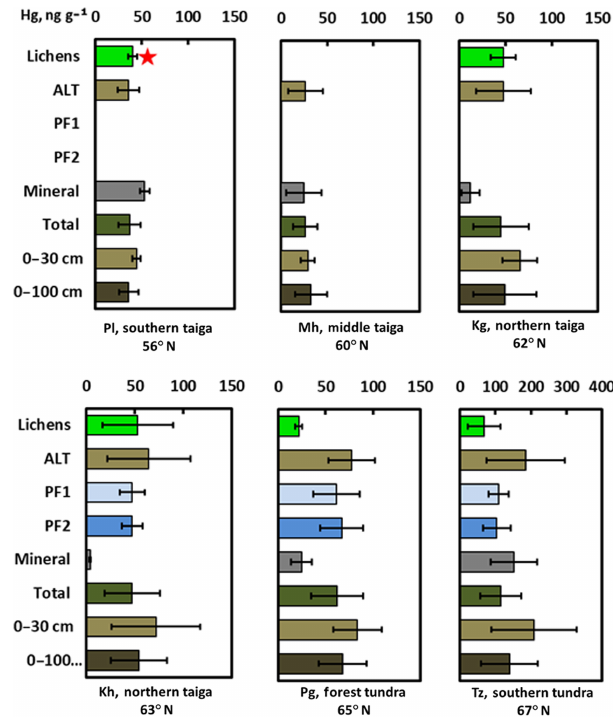
Figure 3. Mean ( ± SD) depth-integrated Hg concentrations in peat columns and mineral layers of six studied sites. The red aster- isk represents the data from Lyapina et al. (2009). ALT is active- layer thickness; PF1 is frozen peat (ALT − 100cm); PF2 is frozen peat (ALT to mineral layer); “mineral” is mineral layer; “total” is total Hg content averaged over the full sampled depth. ∗ In the permafrost-free zone, the ALT extends from the surface to the min- eral